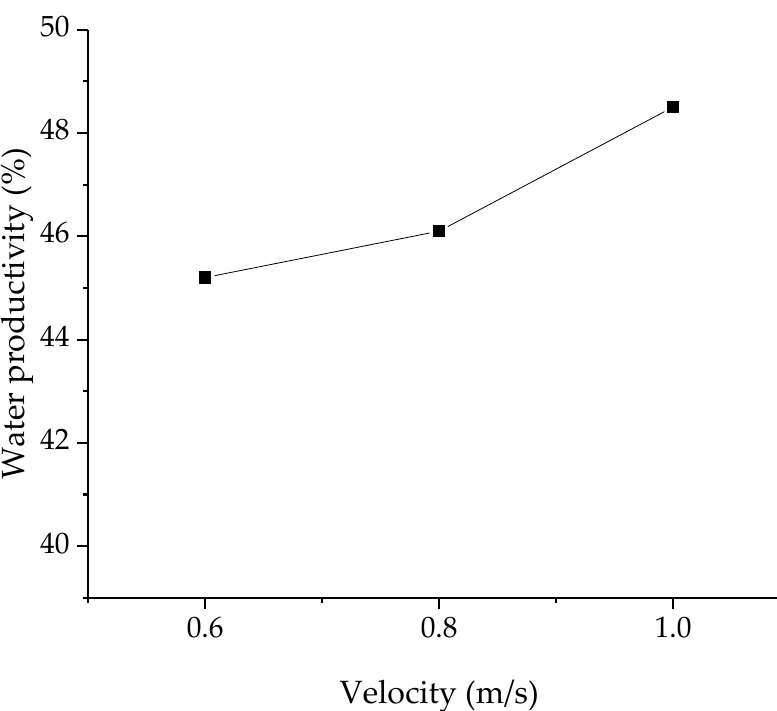
Figure 11. Water productivity with different inlet velocities.